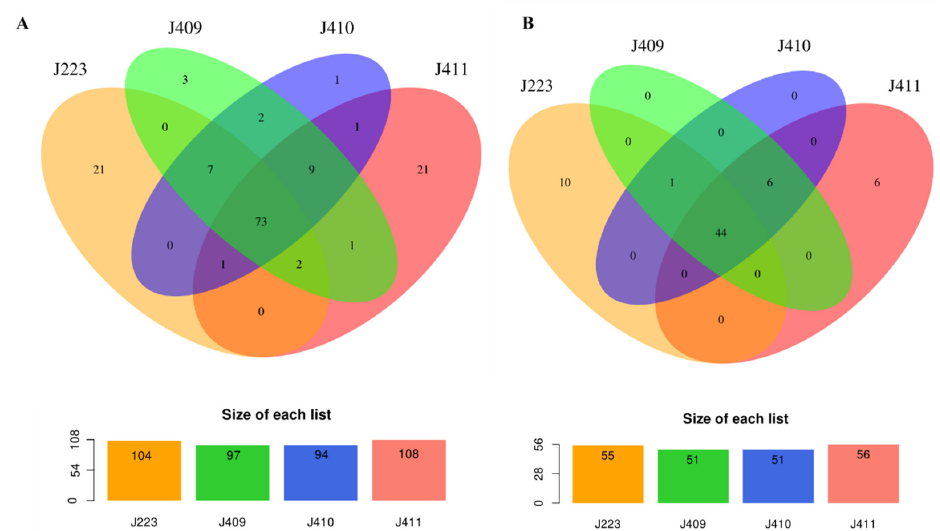
Figure 9. Comparative typical and atypical predicted non-coding RNAs repertory. Venn diagrams show the comparison of ncRNAs repertory identified in typical and atypical strain genomes. ( A ) Graphical representation of total ncRNAs copies identified in typical and atypical A. salmonicida , with the list size of number of ncRNAs copies from each strain; ( B ) Graphical representation of single copy ncRNAs, as unique and common shared ncRNAs identified within typical and atypical strains, with the list size of ncRNAs from each strain.